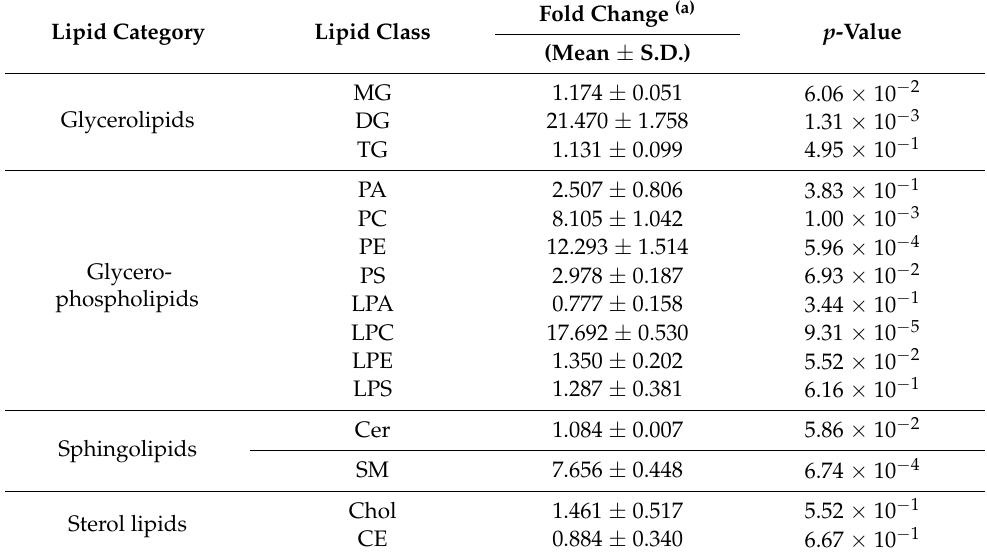
Table 2. Summary of the fold changes of lipid classes in GrEVs relative to those in GrEXs. The fold change values are shown as the means ± standard deviations (n = 9 per group; three biological replicates, each with three technical replicates). Statistical significance was analyzed by Student’s t -tests for two